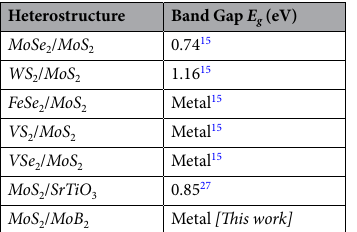
Table 1. Band gaps obtained in other works and present